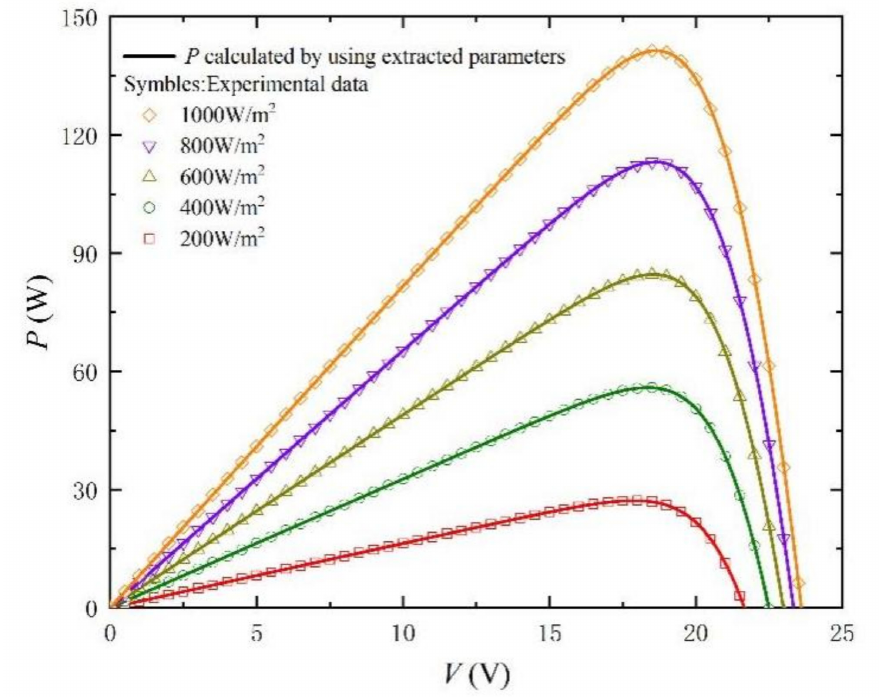
Figure 10. P-V curves measured from experimental data [33] at different irradiance levels and T = 25 ◦ C, and calculated by using the extracted parameters listed in Table